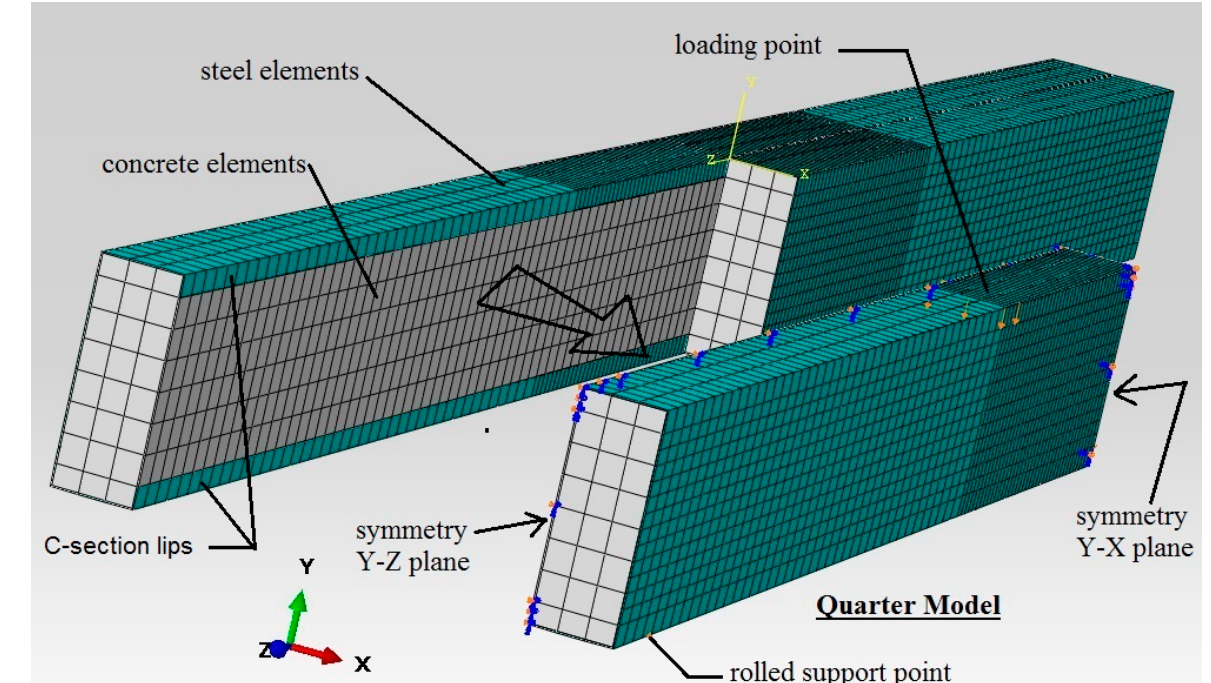
Figure 8. Typical finite element CFST model.